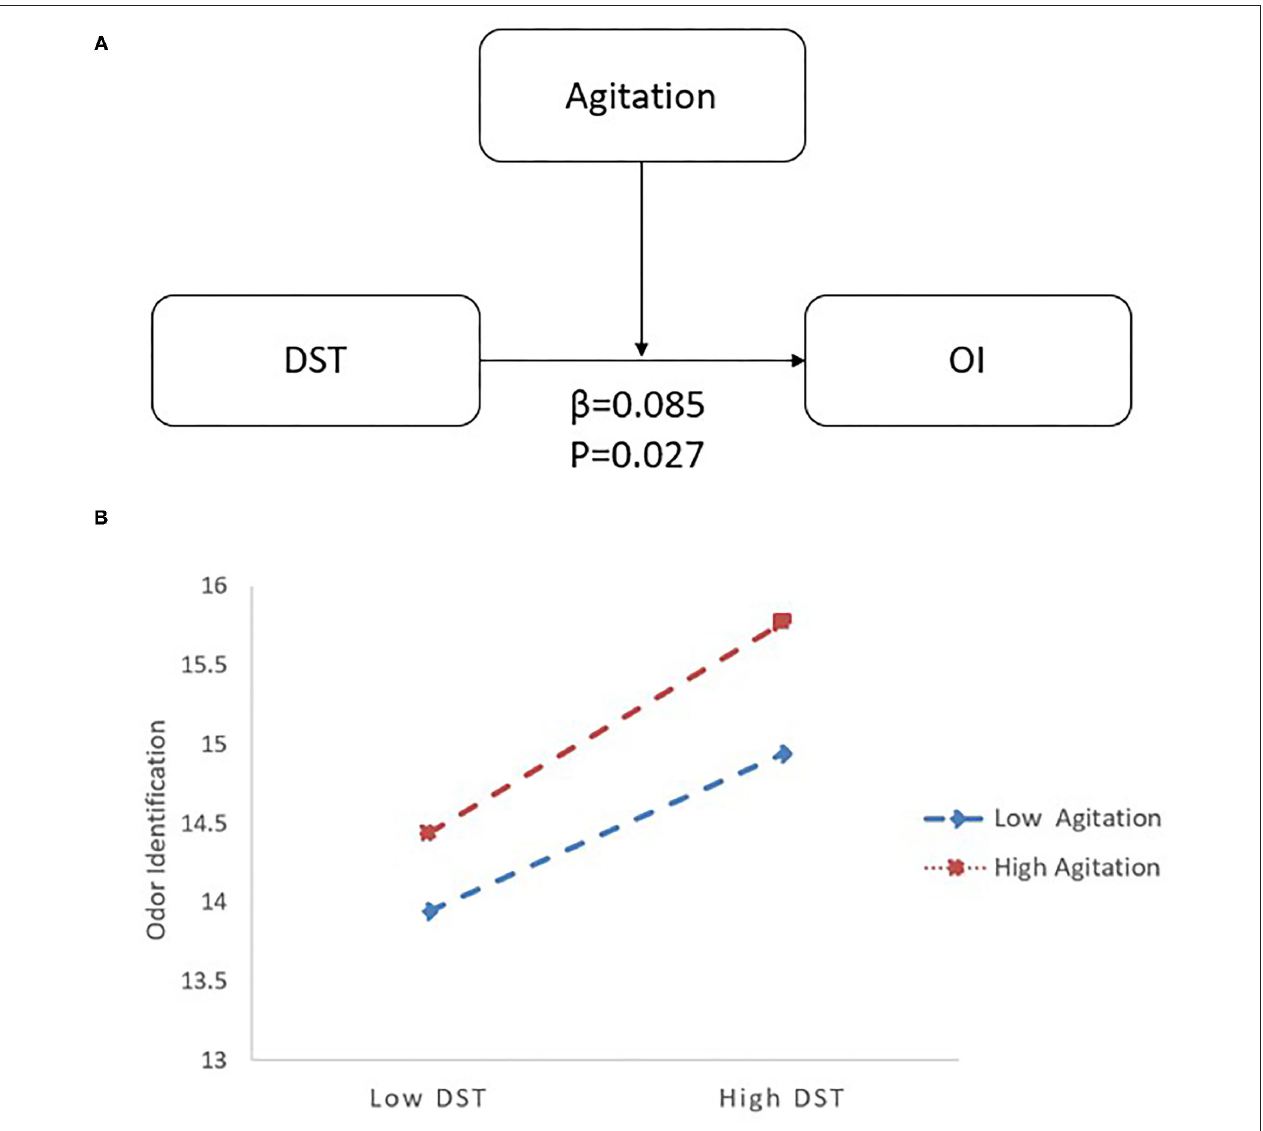
FIGURE 3 | The interactive effect of agitation and DST on OI with LLD. (A) The interactive model among agitation, DST and OI. There is an interactive effect of DST*Agitation ( β = 0.085, p = 0.027) on OI. (B) When agitation increased from low ( − 1 SD; B = 0.134) to high ( + 1 SD; B = 0.440) values, the positive association between DST and OI became significantly stronger by follow-up simple slopes analysis. DST, Digital Span Test; OI, odor identification; LLD, late-life depression.